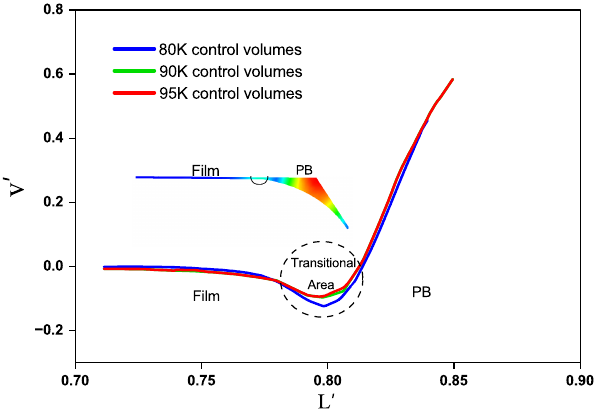
Figure 2. Scaled velocity profiles of different grid densities are shown for 80 k, 90 k and 95 k cells along a line from the PB to the center of the film, which contained three different regions for the PB, transitional area (where Marangoni flow appears), and film. The velocity in the transitional area in the film was dominated by the Marangoni effect and had the highest value in the opposite direction of the gravity force. The color scale shown in the sketched cross-section represents the velocity value where the positive direction is assumed along the gravitation direction. By comparing the velocities to different grids, no significant difference between the results of 90 k and 95 k was seen. Hence, the flow behavior in the net was independent of the grid densities for grids 90 k and higher.